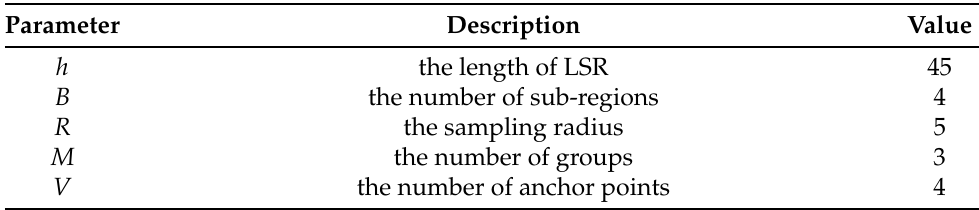
Table 2. Parameters summary.